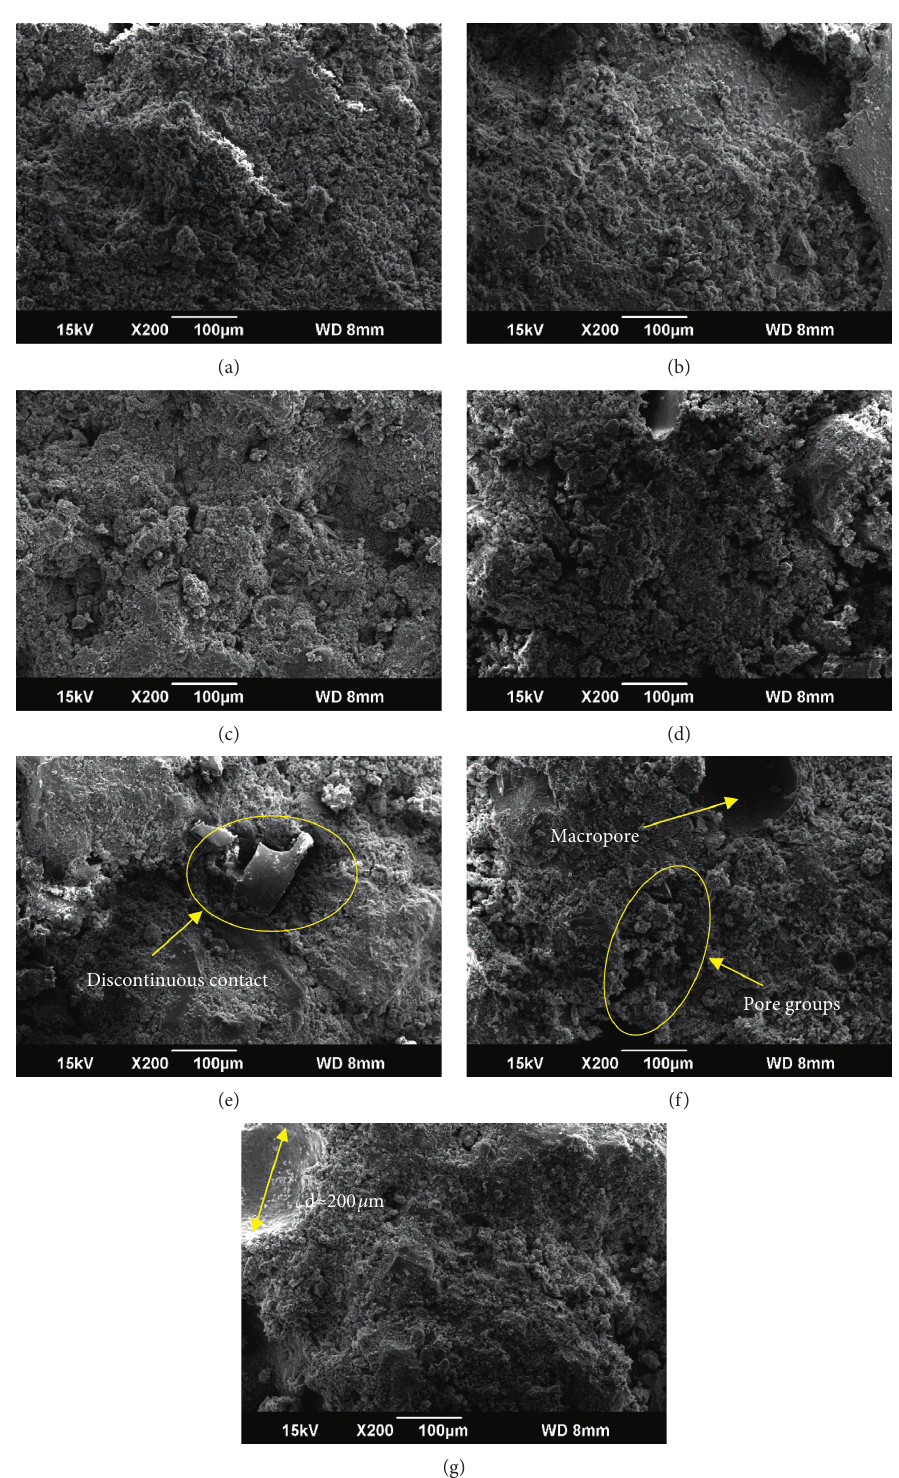
Figure 6: Pores distribution of 28d age CPB formed by slurry with different initial air content. (a) 2.40%. (b) 4.62%. (c) 6.03%. (d) 6.94%. (e) 7.78%. (f) 8.31%. (g)